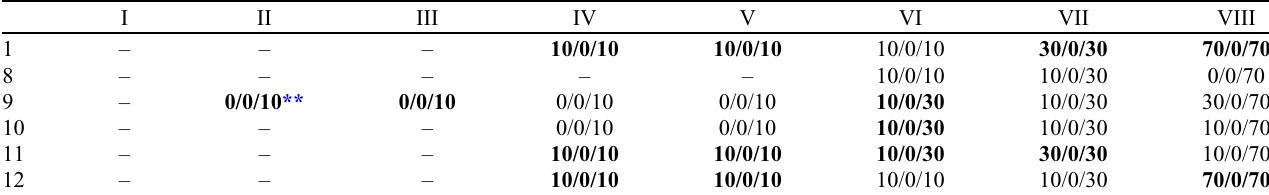
Table 5. Range of predictable rotation in external fixation of the radius * (maximal pronation, neutral, maximal supination).